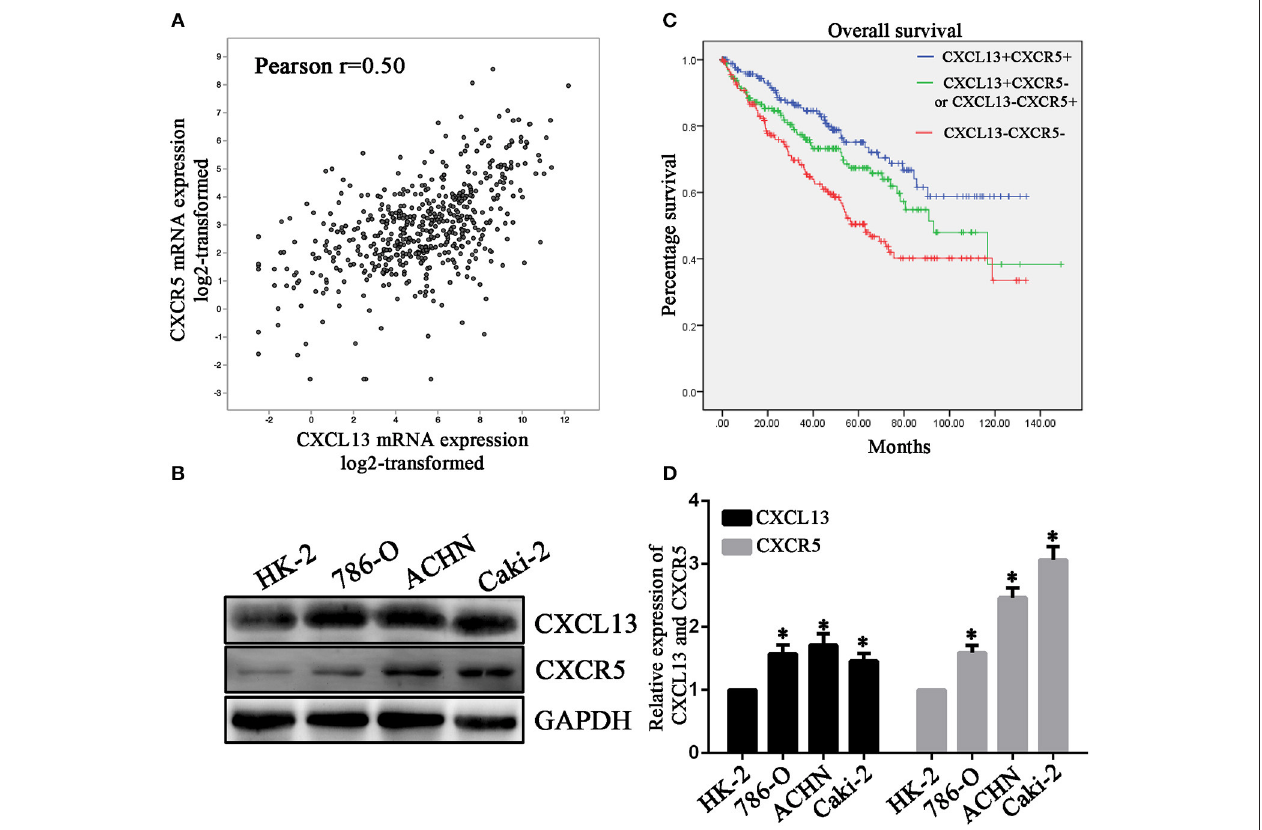
FIGURE 4 | CXCL13/CXCR5 axis might be a potential prognostic marker in ccRCC. (A) Co-expression of CXCL13 and CXCR5 expression in ccRCC tissues (Pearson’s correlation test, ** P < 0.001). (B) Western blotting analysis of CXCL13 and CXCR5 protein level in cell lines. CXCL13 and CXCR5 expression were higher in ccRCC cells (ACHN, 786-O, and Caki-2) than in HK-2 (Student’s t -test, * P < 0.05). (C) Kaplan-Meier analysis of overall survival in CXCL13 + CXCR5 + , CXCL13 + CXCR5 − /CXCL13 − CXCR5 + , and CXCL13 − CXCR5 − ccRCC patients. (D) ccRCC patients in CXCL13 + CXCR5 + group have a worst overall survival